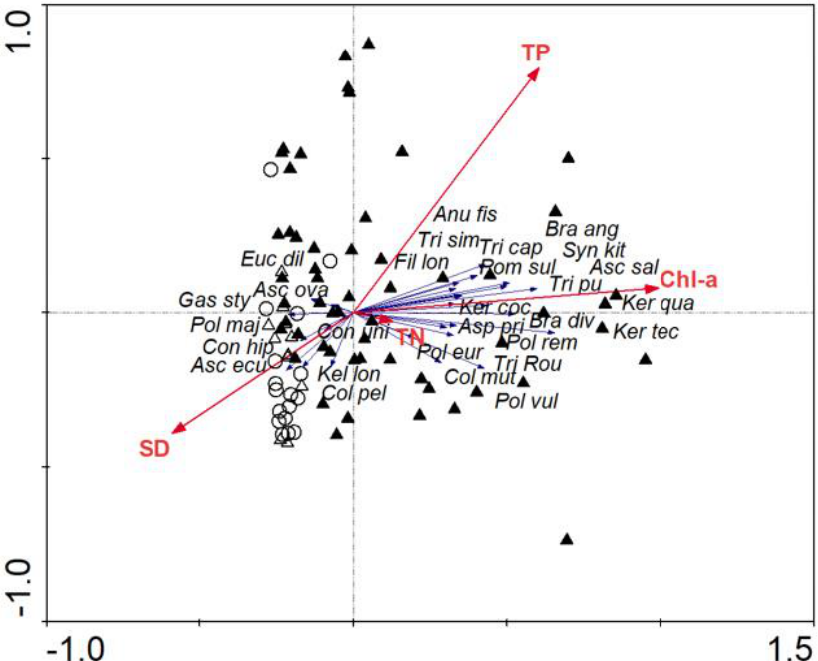
Figure 5. The distribution of the reference (circle) and non-reference lakes (triangles) and the Rotifera species (blue arrays) in the RDA space determined by four environmental viariables (red arrays): Secchi disc visibility (SD), chlorophyll- a concentration (Chl – a ), total phosphorus (TP). Rotifera spe-